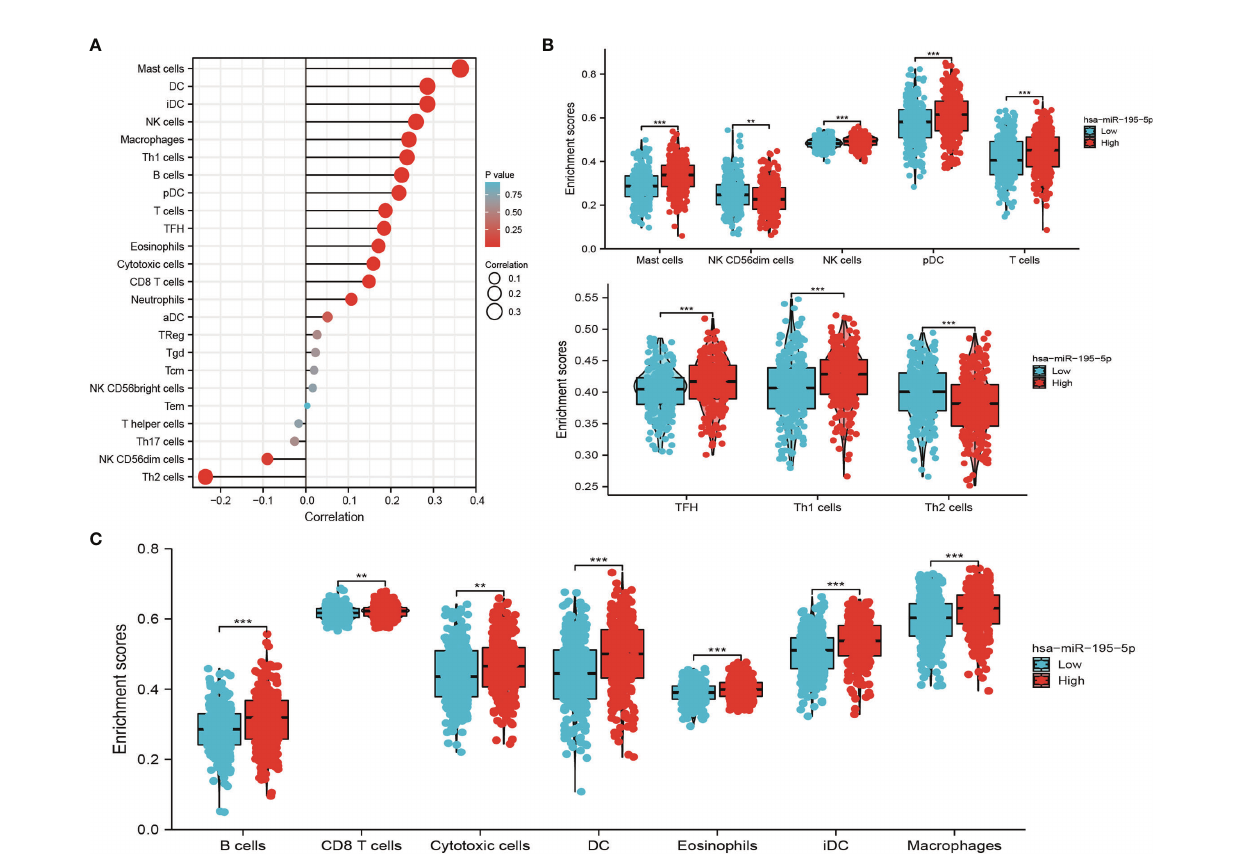
FIGURE 7 | Analysis of the correlation between miRNA-195-5p expression and immune in fi ltration. (A) Correlation between the relative abundances of 24 immune cells and miRNA-195-5p expression level. (B, C) Diverse proportions of immune cell subtype in tumor samples in high and low miRNA-195-5p expression groups. **P<0.01;